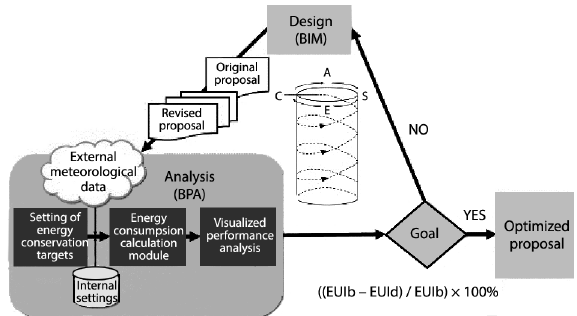
Figure 6. The linkage between sustainable design, BPA, and BIM (Andrasik, 2015) Figure 7. Stage 1 of integrated green BIM design